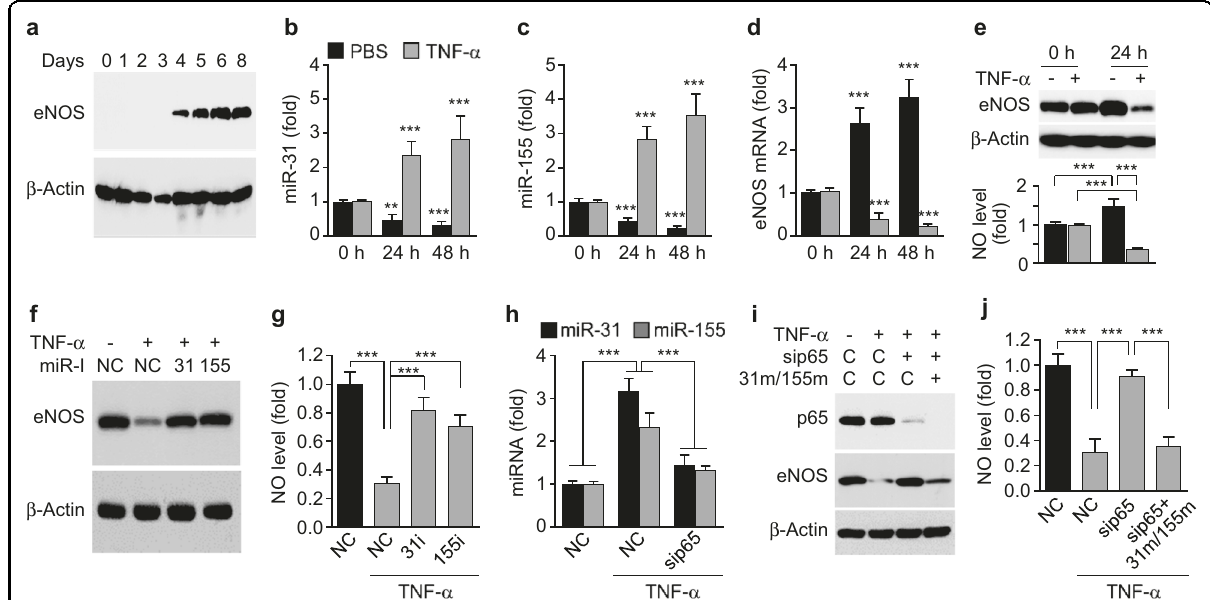
Fig. 4 TNF- α inhibits eNOS expression via NF- κ B-dependent induction of miR-31/155. a The expression pattern of eNOS during the differentiation of CBMNCs into EPCs. b – e CBMNCs were stimulated with or without TNF- α (10 ng/ml) for the indicated time periods. Quantitative levels of miR-31 ( b ), miR-155 ( c ), eNOS mRNA ( d ), and eNOS protein and NO production ( e ) were determined by qRT-PCR, western blotting, and confocal microscopy ( n = 4). ** P < 0.01 and *** P < 0.001 vs . the initial control level. f , g CBMNCs were transfected with miRNA inhibitor negative control (NC) or miRNA inhibitors (miR-I; 31i, miR-31 inhibitor and 155i, miR-155 inhibitor), followed by treatment with TNF- α for 2 days. The levels of eNOS protein and NO production were determined by western blotting and confocal microscopy, respectively ( n = 4). *** P < 0.001. h – j CBMNCs were transfected with AllStars negative control (NC or C), NF- κ B p65 siRNA (sip65), or miR-31/155 mimics (31 m/155 m), followed by stimulation with TNF- α for 24 h. h – j The levels of miR-31 and miR-155 ( h ), eNOS protein ( i ), and NO production ( j ) were analyzed ( n = 4). *** P < 0.001.